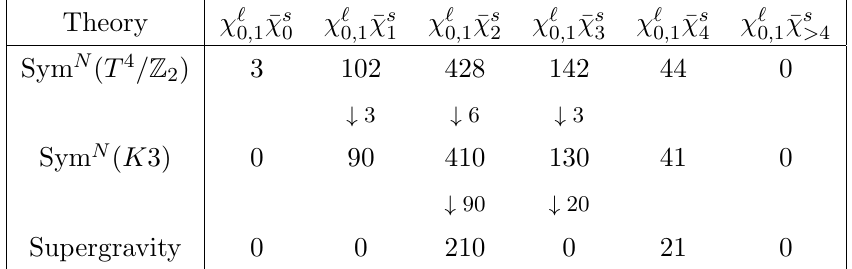
Table 4 . Coe(cid:14)cients of all short characters multiplying (cid:31) ‘ the supergravity region. These are the coe(cid:14)cients d next to a downward-pointing arrow below short multiplet (cid:22) (cid:31) s j combining with n of type j (cid:0) 1 and j + 1 to form n long multiplets.